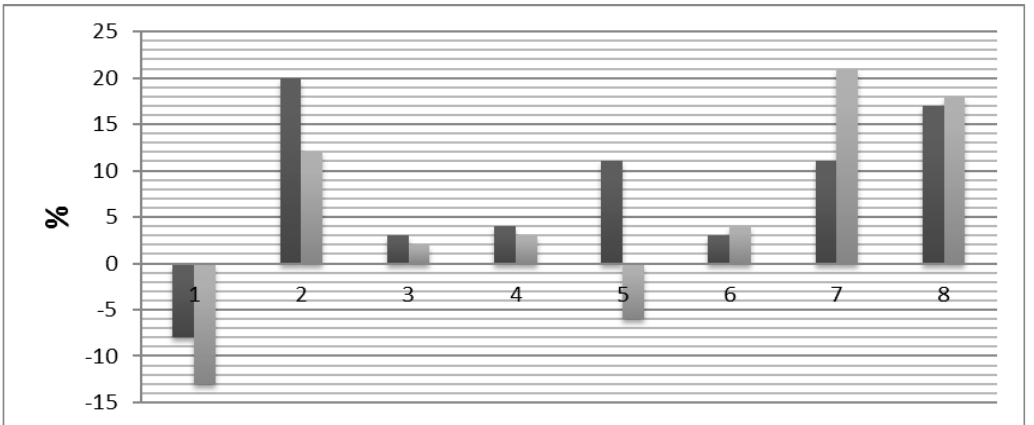
Fig. 6 . Changes of pedaling bio-mechanical characteristics of elite cyclists in periods of fatigue’s overcoming and evident fatigue during trainings of anaerobic orientation.